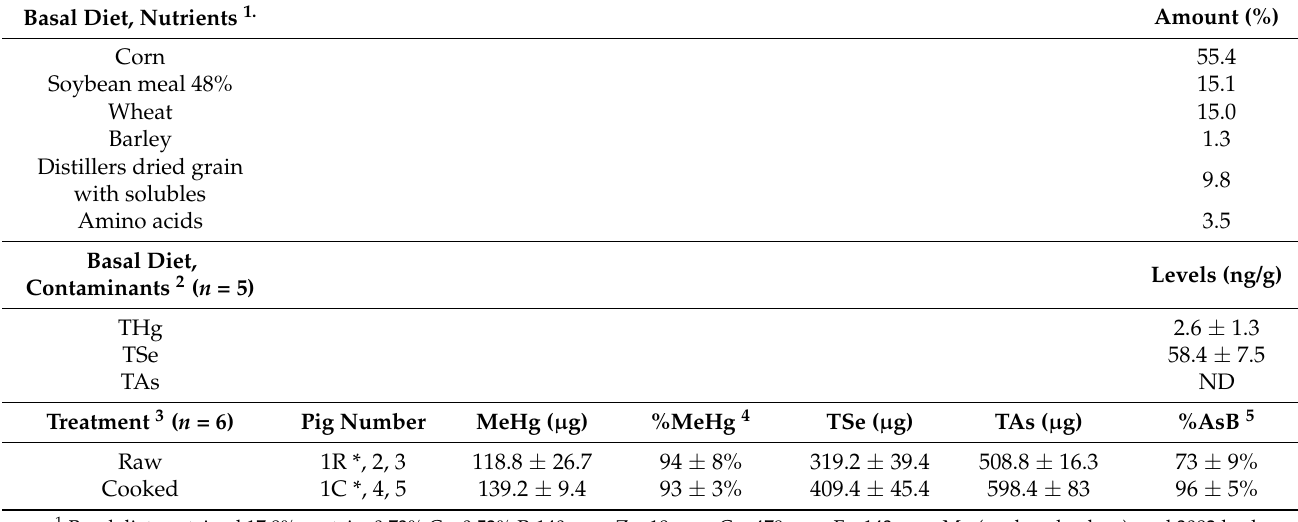
Table 1. Conventional basal diet for growing pigs and treatments. Metal(loid)s values (wet weight) are presented as average ± standard error. Basal Diet, Nutrients